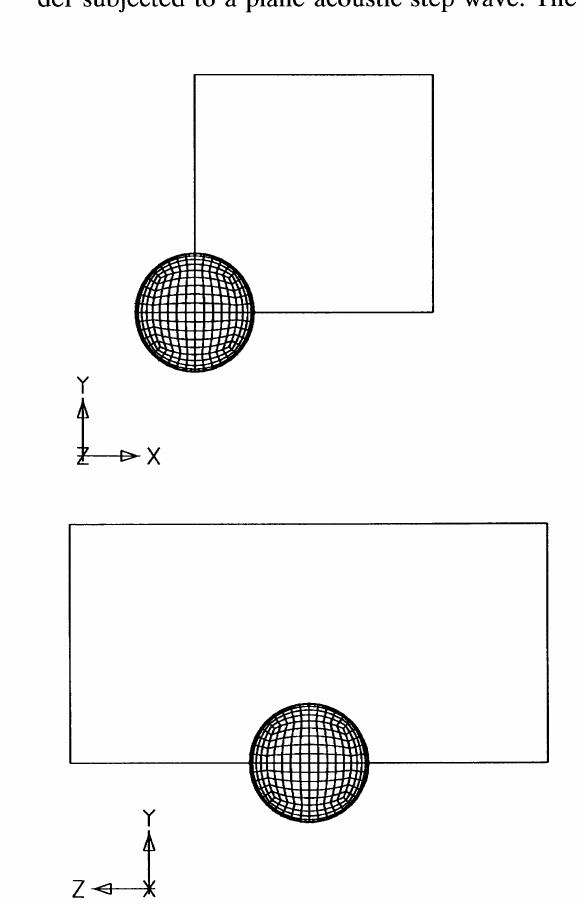
FIGURE 5 Size and position of the spherical shell relative to the Eulerian fluid volume for the spherical shell/plane step wave